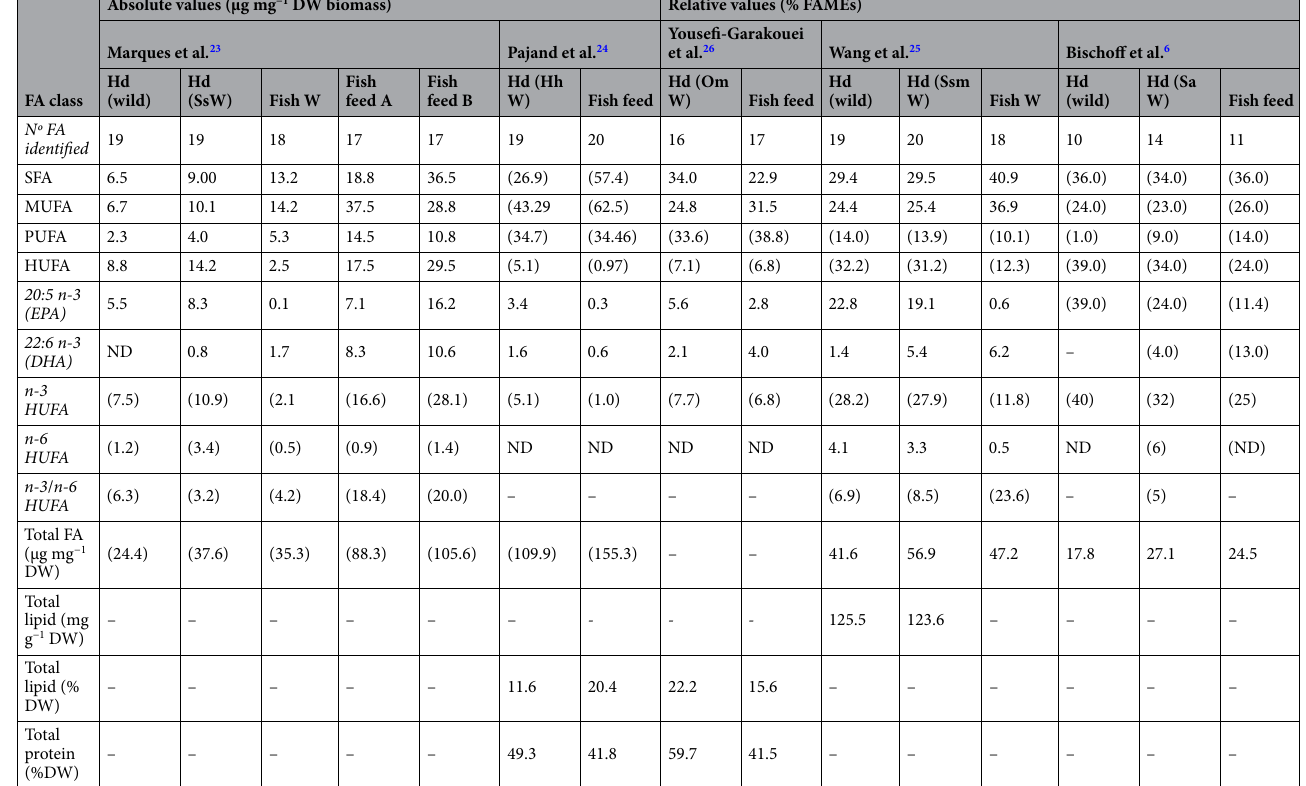
Table 4. Summary of the results of FA characterisation obtained in studies where the species H. diversicolor where included in IMTA designs . Table summarizes the FA characterisations of wild and IMTA-cultured Hediste diversicolor (Hd) depending on the origin of wasted nutrients: SsW— Solea senegalensis waste; Hh W— Huso huso waste; Om W— Onchorhynchus mykiss waste; Ssm W—salmon smolt waste; Sa W— Sparus aurata waste. Other FA characterisations corresponded to fish W (waste—faeces and uneaten feed) and fish feed. PUFA defined as all FA with ≥ 2 double bonds and HUFA all FA with ≥ 4 double bonds (not considered within ∑PUFA). The values between brackets were estimated based on the FA profile reported in each